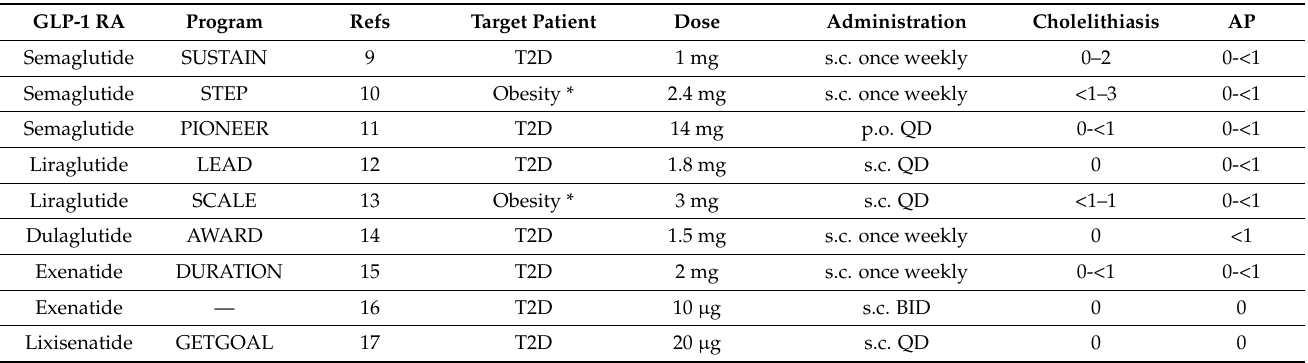
Table 3. Frequency of pancreatobiliary complications in clinical trials with GLP-1 RA in people with obesity or